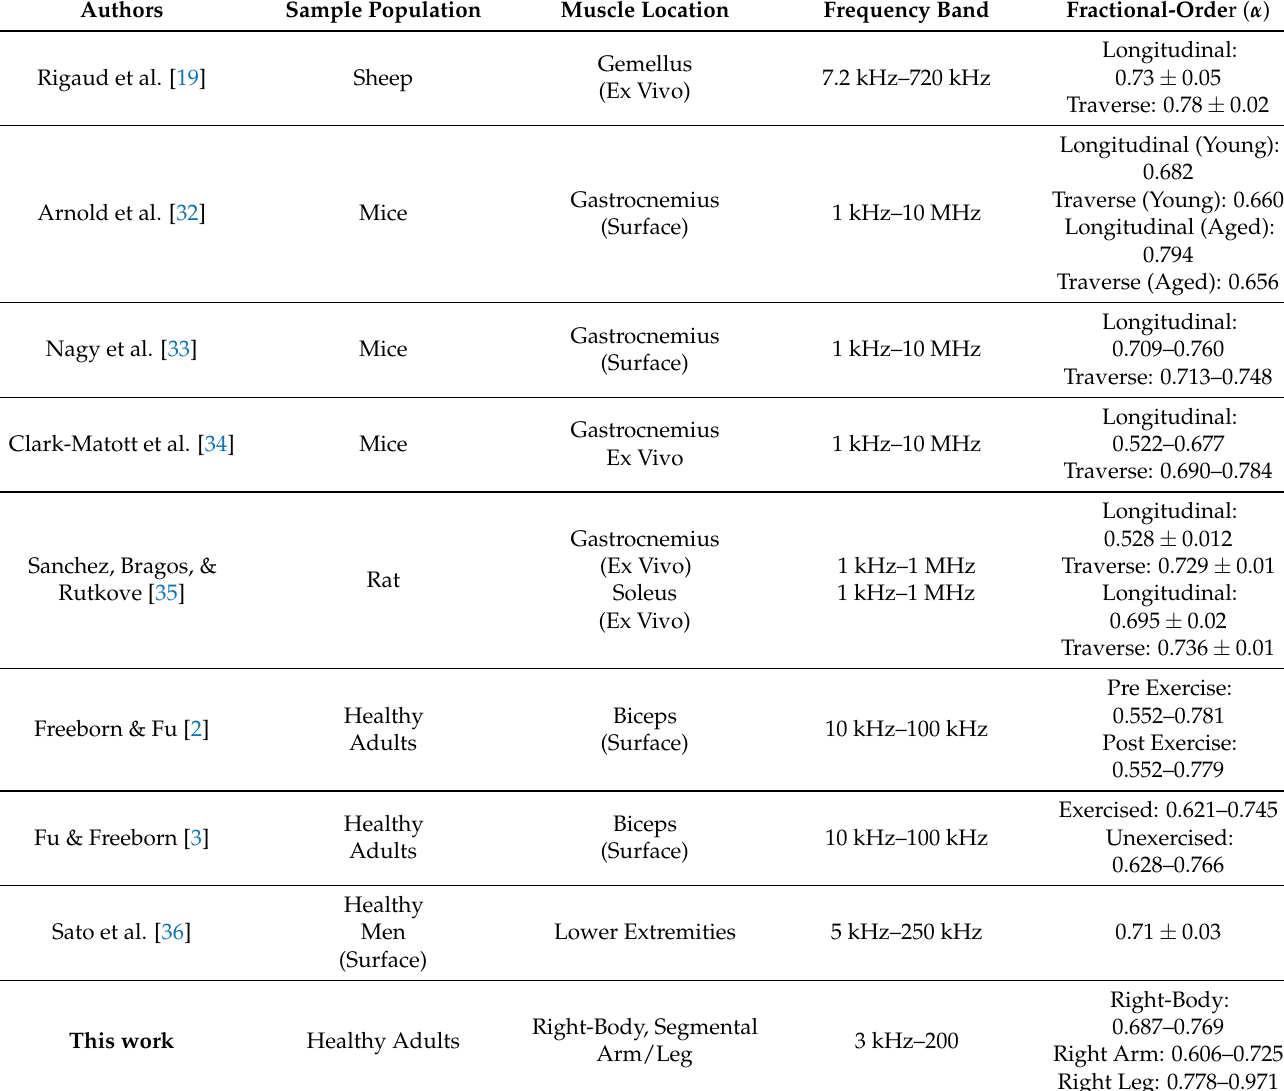
Table 3. Summary of fractional-order ( α ) reported from studies of skeletal muscle tissue impedance utilizing Cole-impedance